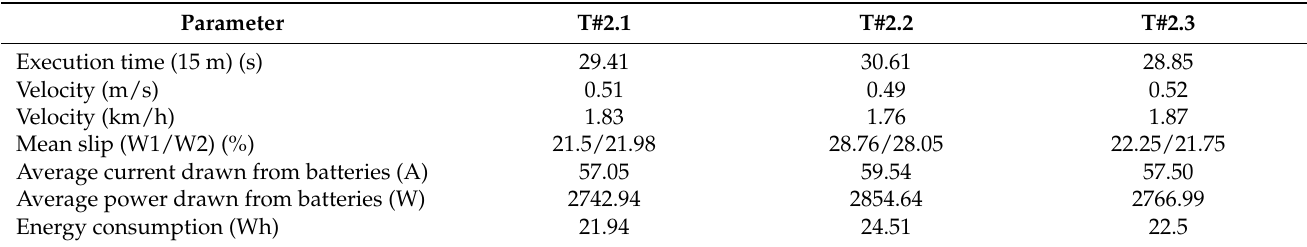
Figure 24. Energy consumption during the trial sessions carried out on firm soil with the slip man- ually controlled by the operator. Table 2. Summary of parameters measured during the trial sessions carried out on firm soil with the slip manually controlled by the operator.